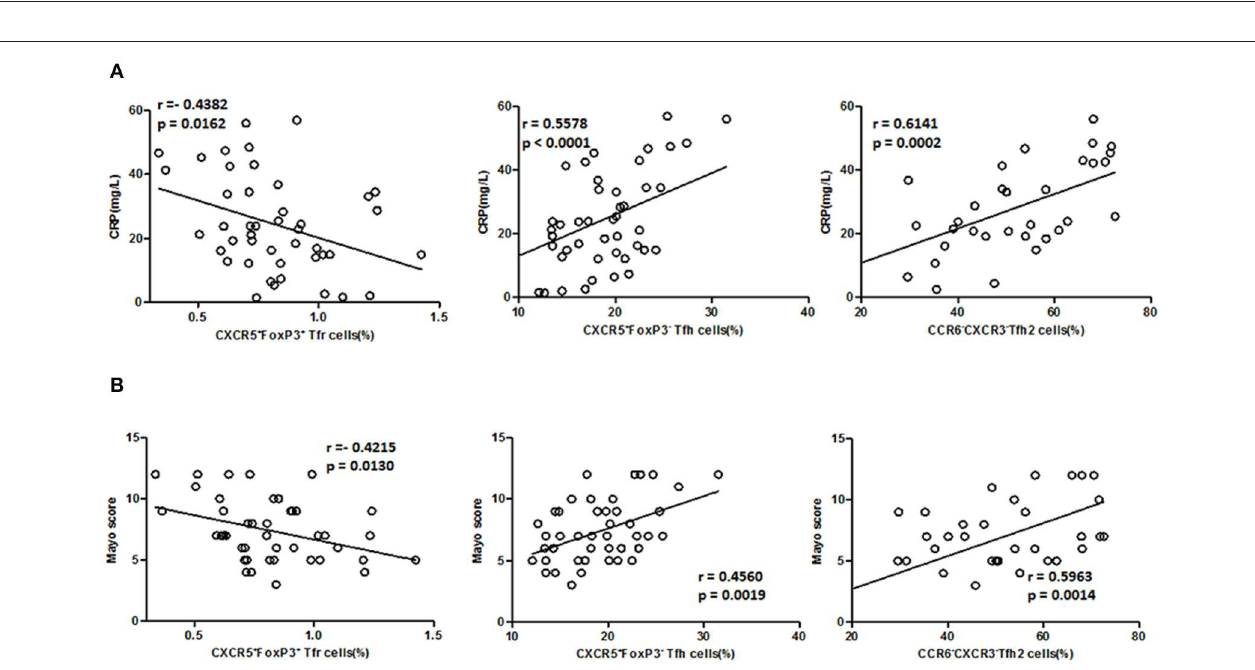
FIGURE 5 | Correlation between TFR, TFH, TFH2 subsets, and clinical parameters in active UC patients. (A) Levels of CRP in active UC patients were measured, and correlation analysis with percentages of CD4 + CXCR5 + FoxP3 + TFR cells ( n = 44), CD4 + CXCR5 + FoxP3 − TFH cells ( n = 44), CXCR3 − CCR6 − TFH2 subsets ( n = 32) were performed. (B) The disease activity of UC was evaluated by Mayo Clinic Score, and correlations with TFR and TFH cells in active UC patients ( n = 44), and with percentages of TFH2 cells in active UC patients ( n = 32) were performed. The r-values were the Spearman’s correlation coefficients, and p < 0.05 was linearly regressed to show relevant